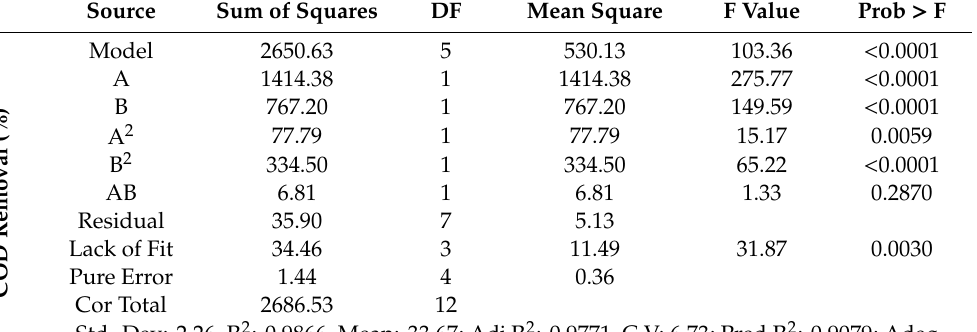
Table 4. Analysis of variance (ANOVA) for COD, total suspended solids (TSS), color and NH 3 –N